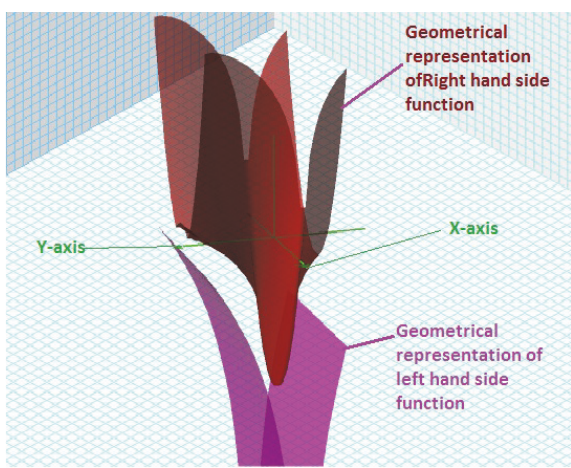
Figure 5: Plot of inequality for verification of Condition